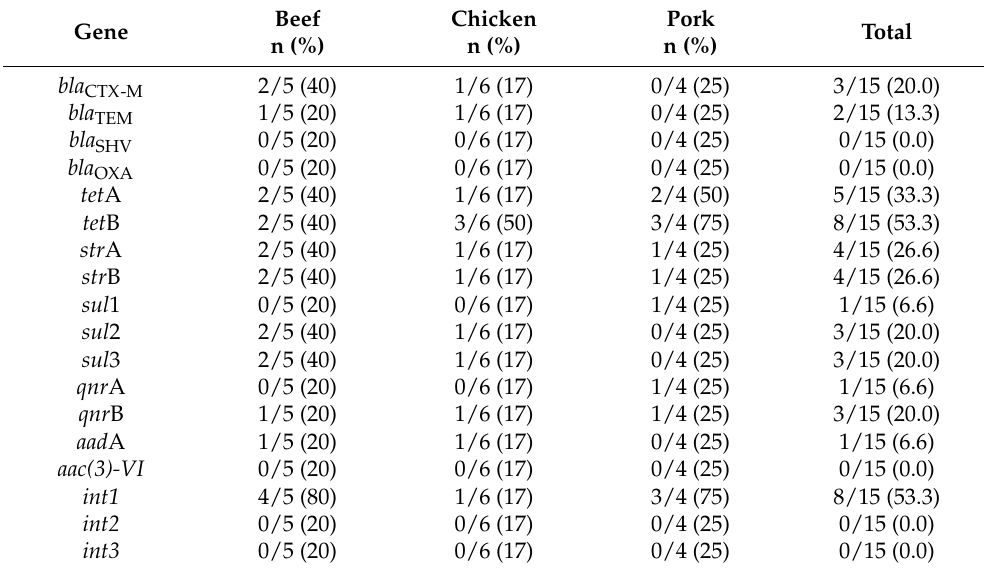
Table 2. Antimicrobial resistance genes to ESBL-producing E. coli strains according to the type of meat.